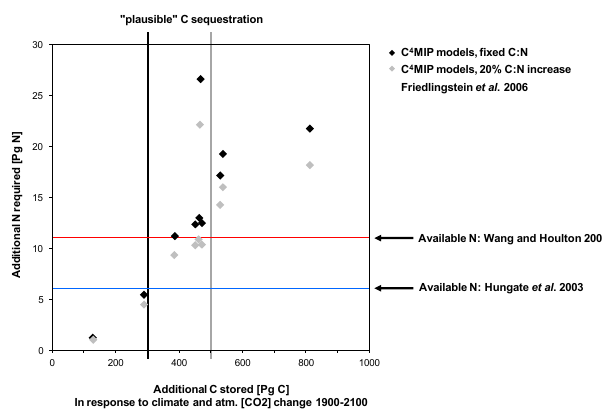
Fig. 7. Nitrogen constraints of carbon sequestration. The original analysis by Hungate et al. (2003) was based on some biogeochemi- cal principles to reveal major deficiencies in global biogeochemical models. The analysis may not be considered as a typical benchmark analysis, but it played a role in stimulating global modeling groups to incorporate nitrogen processes into their models. However, rela- tive performance skills of land models as measured by the bench- mark analysis vary with additional considerations of data sets, as illustrated in analysis on flexibility of C:N ratio by Wang and Houl- ton (2009). Moreover, nitrogen capital in the terrestrial ecosystem is considerably dynamic in response to rising atmospheric CO 2 con- centration (Luo et al., 2006), rendering less limitation of ecosystem carbon